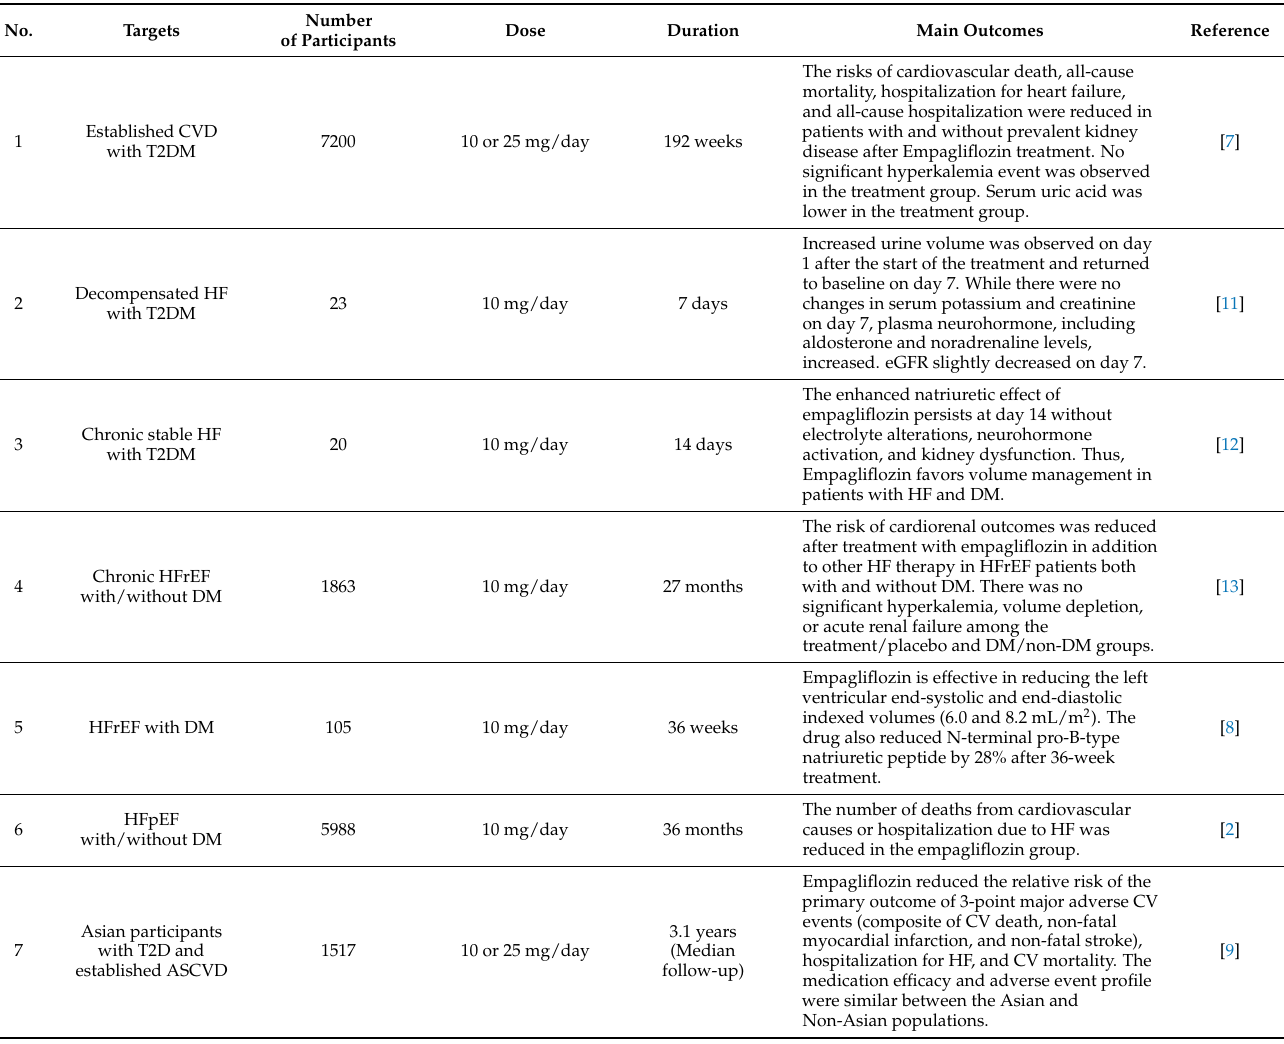
Table 1. Summary of selected clinical trials showing effects of empagliflozin on heart failure in patients with diabetes